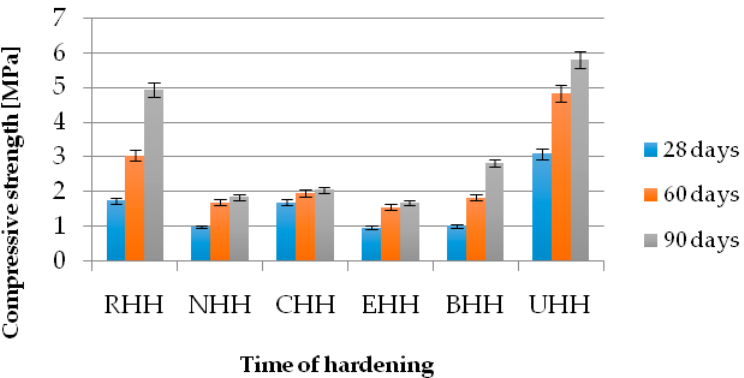
Figure 4. Water absorption of the original and treated hemp composites after 28, 60, and 90 days of hardening.